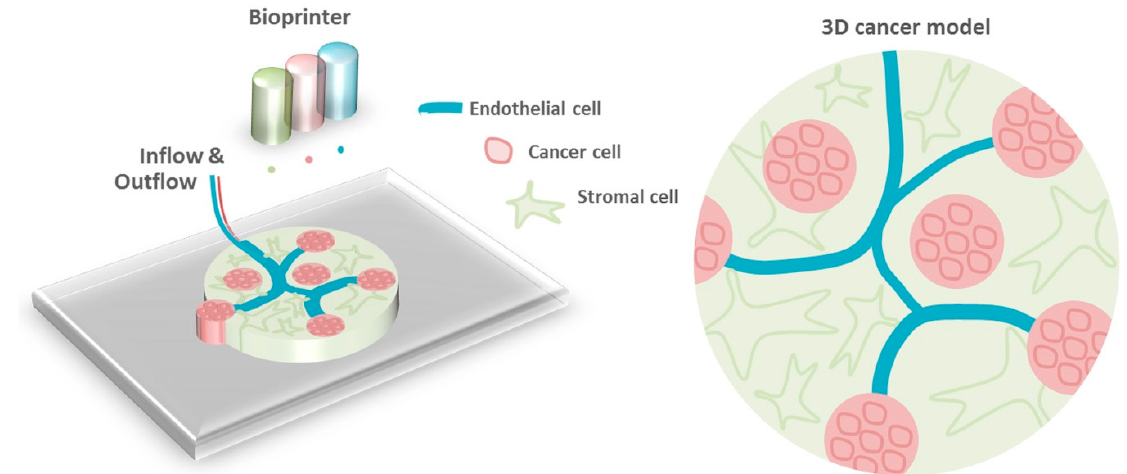
Figure 1. Schematic representation of the proof-of-principle experiment of a cell-free 3D cancer model. Cell-free 0.5% agarose (AG)-0.2% collagen (COL) bioprintable bioink mixed with three different colors